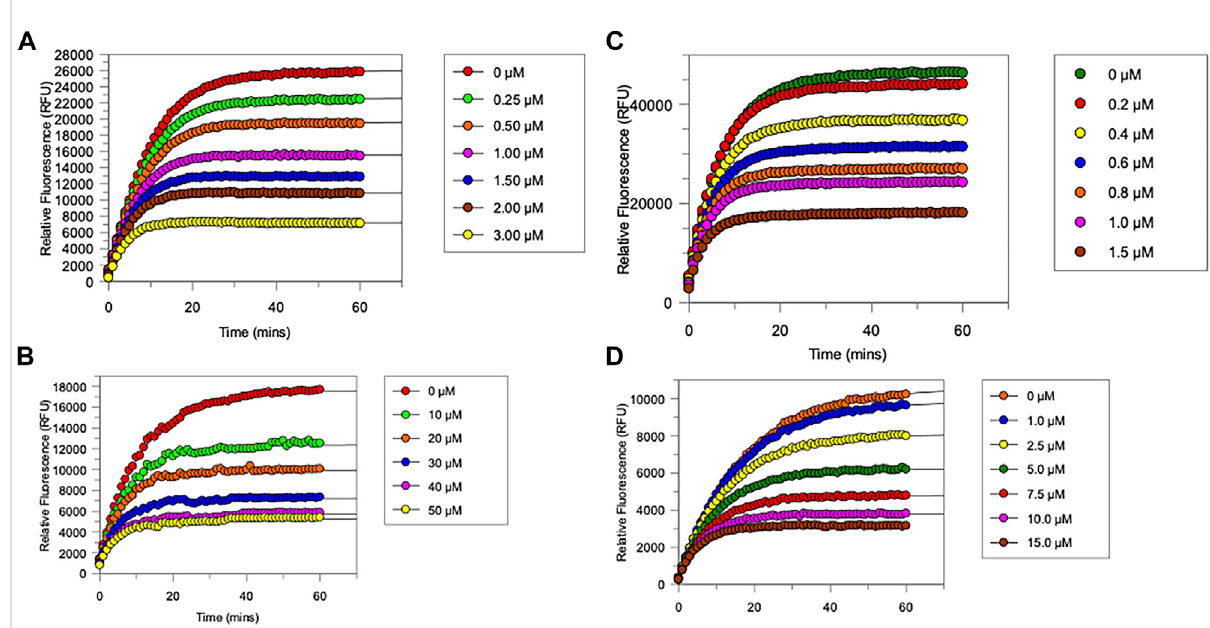
FIGURE 4 Progress curves for (A) , chymotrypsin-catalysed hydrolysis of Succinyl-Ala-Ala-Pro-Phe-NHMec, in the presence of varying concentrations of NAP849. (B) ,NE-catalysed hydrolysis ofMeO-succinyl-Ala-Ala-Pro-Val-NHMec,inthepresenceof varyingconcentrationsof NAP800. (C) Trypsin- catalysed of Z-Gly-Gly-Arg-NHMec, in the presence of NAP830. (D) Plasmin-catalysed hydrolysis of Boc-Val-Leu-Lys-NHMec, in the presence of varying concentrations of NAP962. Assays were carried out in PBS, pH 7.4, at 37 ° C, in the presence of a range of inhibitor concentrations